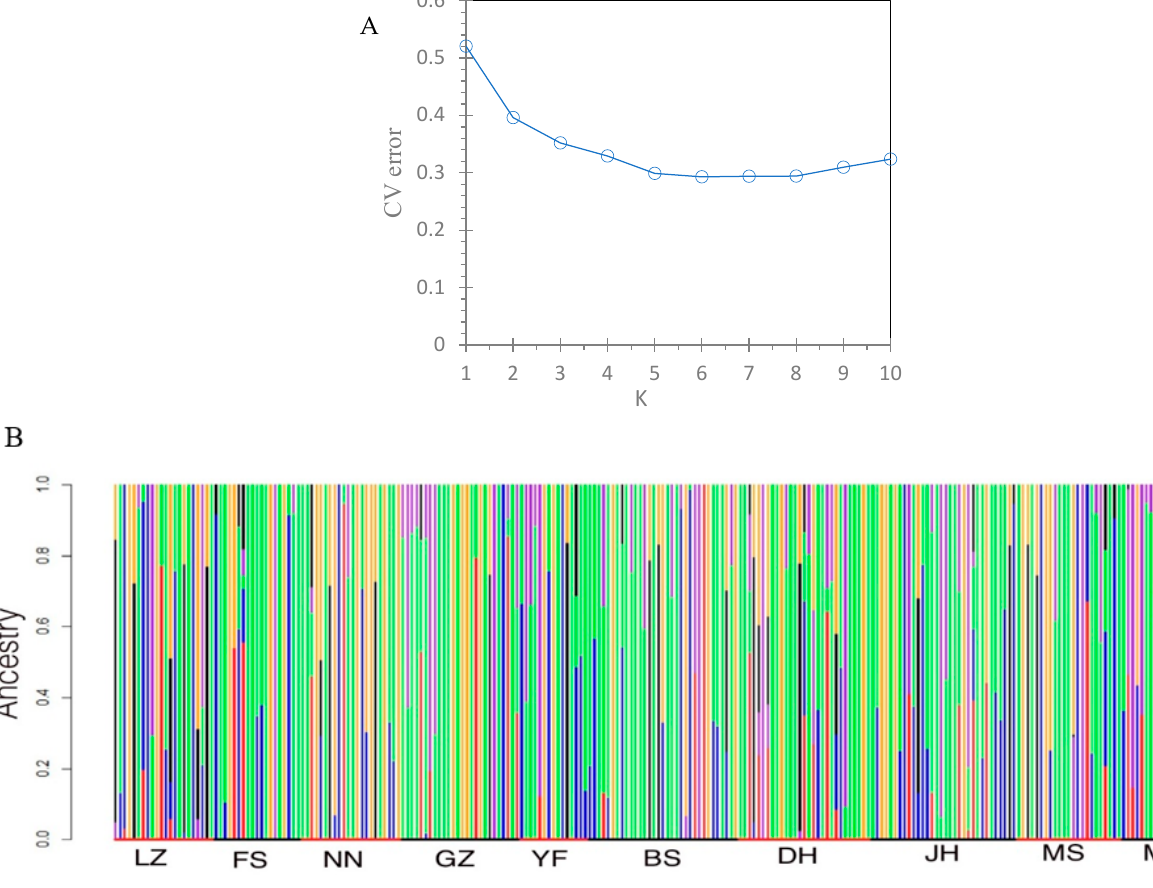
Figure 6. Population structure analysis of 239 individuals of N. cadamba . ( A ) Cross-validation (CV) errors for the number of subpopulations ( K ) changing from 1 to 10. ( B ) A partitioned map of each subpopulation with clustering assignments indicated in different colors.